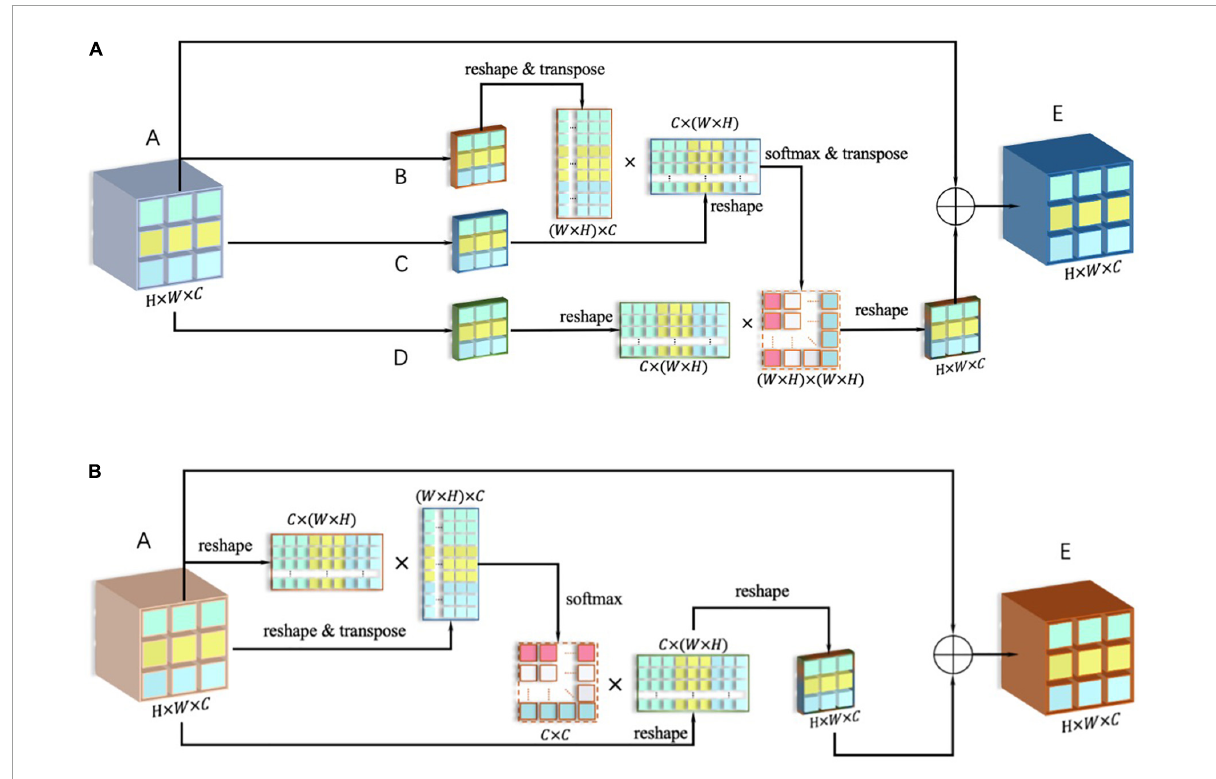
FIGURE2 (A) Framework of position attention module; (B) framework of channel attention